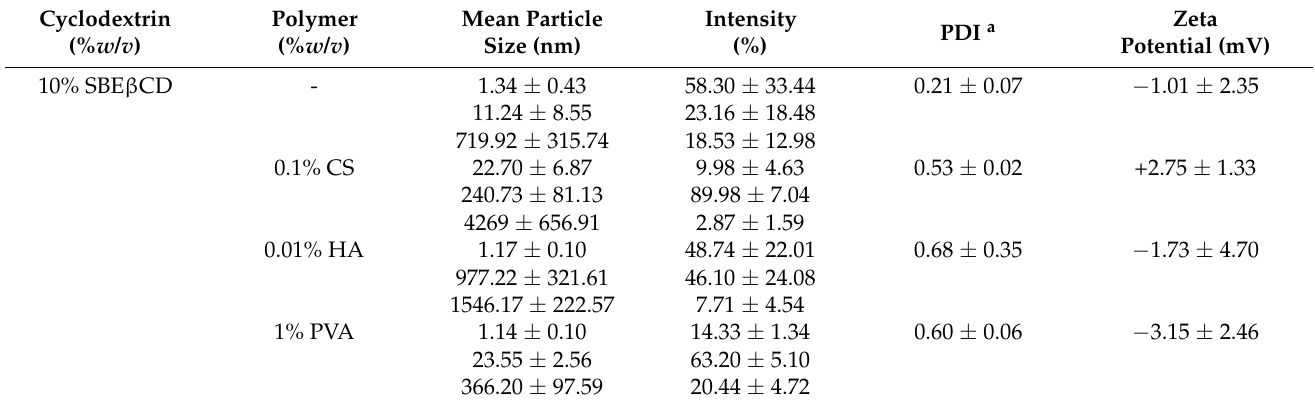
Table 3. Mean particle size, size distribution and zeta potential of binary VCZ/SBE β CD and